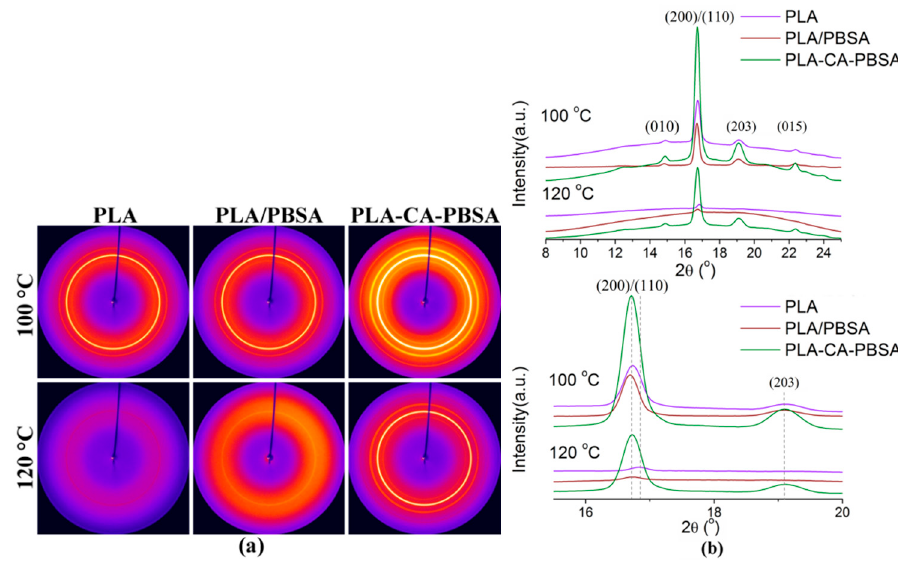
Figure 4. ( a ) 2D-WAXD patterns and ( b ) 1D-WAXD intensity profiles extracted from the corresponding 2D-WAXD patterns for PLA, PLA/PBSA and PLA-CA-PBSA.